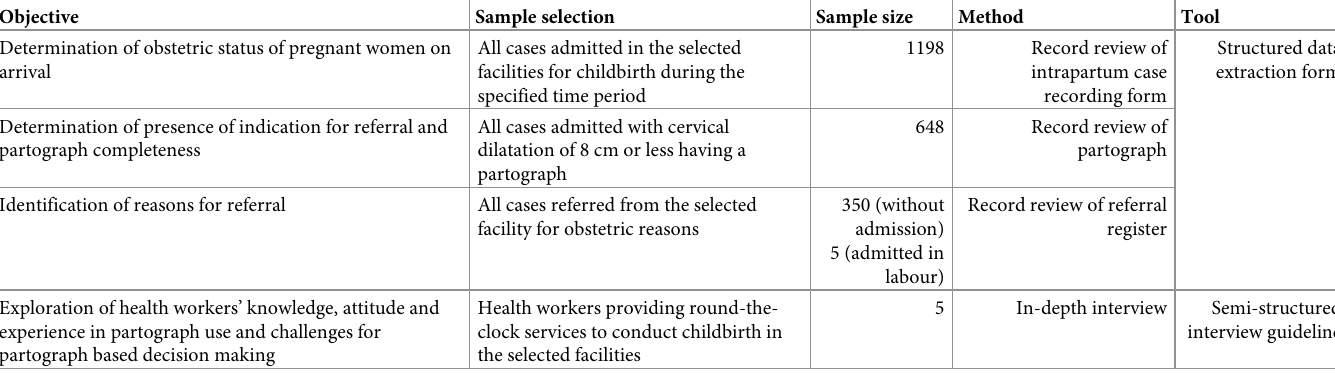
Table 2. Specific objectives, selection of samples and proposed